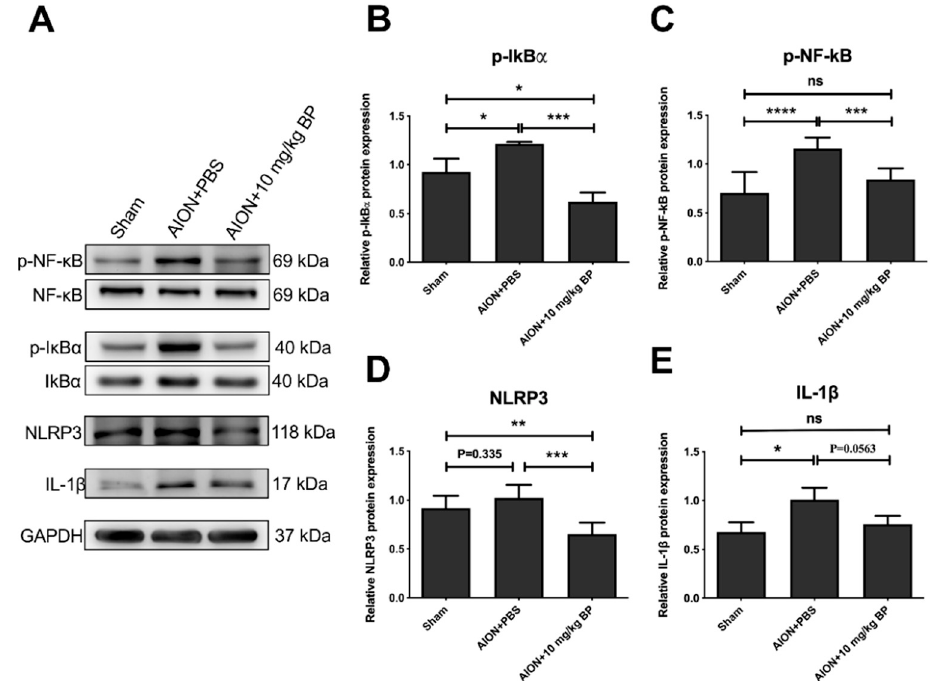
Figure 8. Western blotting revealed the molecular mechanisms of BP treatment in the rAION model. Qualitative blot images of NF- κ B, p-NF- κ B, I κ B α , p-I κ B α , NLRP3, IL-1 β , and GAPDH ( A ). Bar graphics display the relative density of each protein signal ( B – E ). Values of the sham group were set to 1. (****, p ≤ 0.0001; ***, p ≤ 0.001; **, p ≤ 0.01; *, p ≤ 0.05. n.s., not significant.)